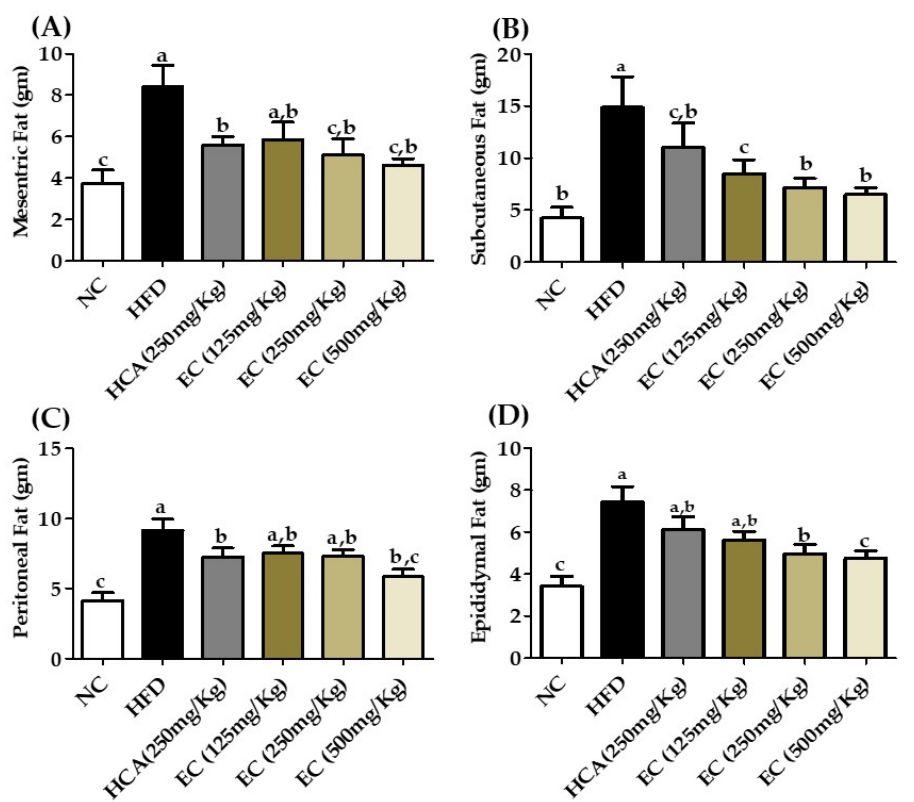
Figure 5. Changes in organ fat, including mesenteric fat ( A ), subcutaneous fat ( B ), peritoneal fat ( C ), and epididymal fat ( D ) weights among rats fed with a normal diet (NC), a high-fat diet (HFD), or HFD accompanied by treatment with ECE at different doses of 125 mg (T1); 250 mg (T2), and 500 mg (T3) per kg BW. Data are presented as means ± SEM ( n = 8 for each group). Values with different letters present significant differences ( p < 0.05).